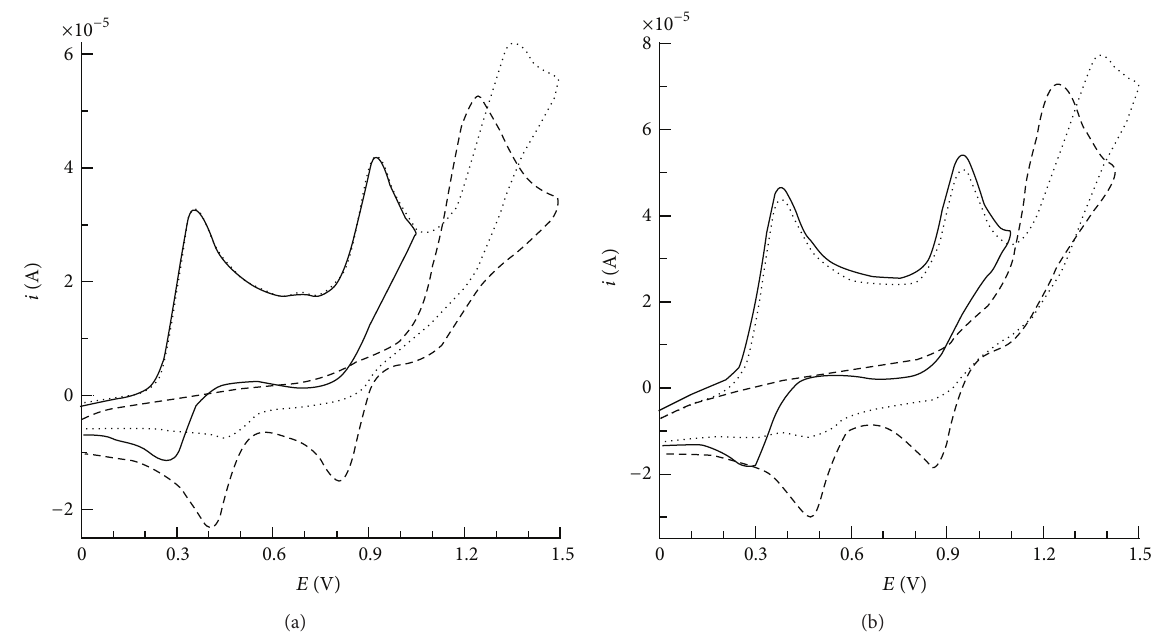
Figure 4: (a) CV curves of 2.0 mM of chemosensor 1 in absence (—: inversion potential 𝐸 𝑖 = 1 V; ∙ ∙ ∙ : inversion potential 𝐸 𝑖 = 1.5V) and in presence of 1.0 mM of Cd 2+ (– – –). (b) CV curves of 2.0 mM of chemosensor 2 in absence (—: inversion potential 𝐸 𝑖 = 1V; ∙ ∙ ∙ : inversion potential 𝐸 𝑖 = 1.5V) and in presence of 0.5 equivalent of Cd 2+ (– – –). Voltammograms were recorded in ACN containing 0.1 M TBABF 4 as supporting electrolyte. Working electrode: glassy carbon; reference electrode: SCE (KCl 3 M); scan rate: 0.1Vs −1